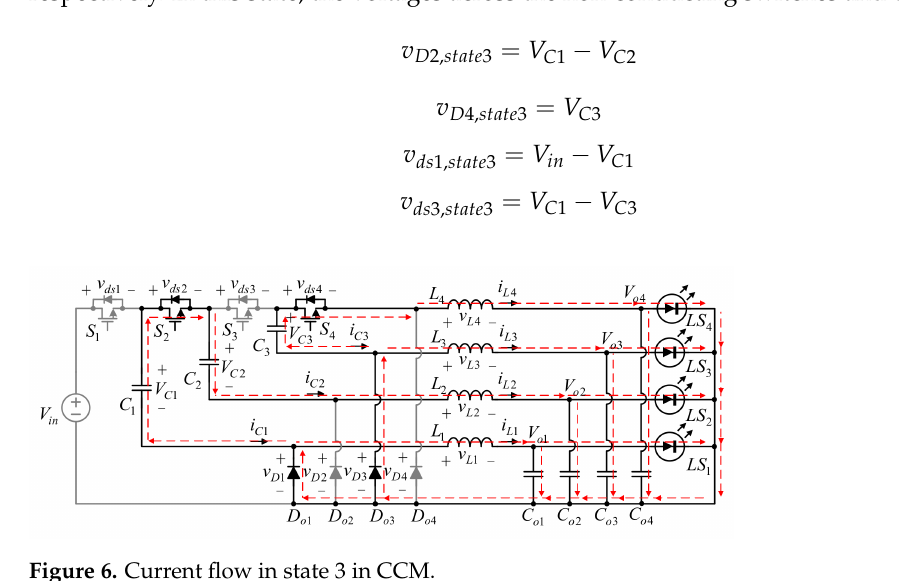
Figure 6. Current flow in state 3 in